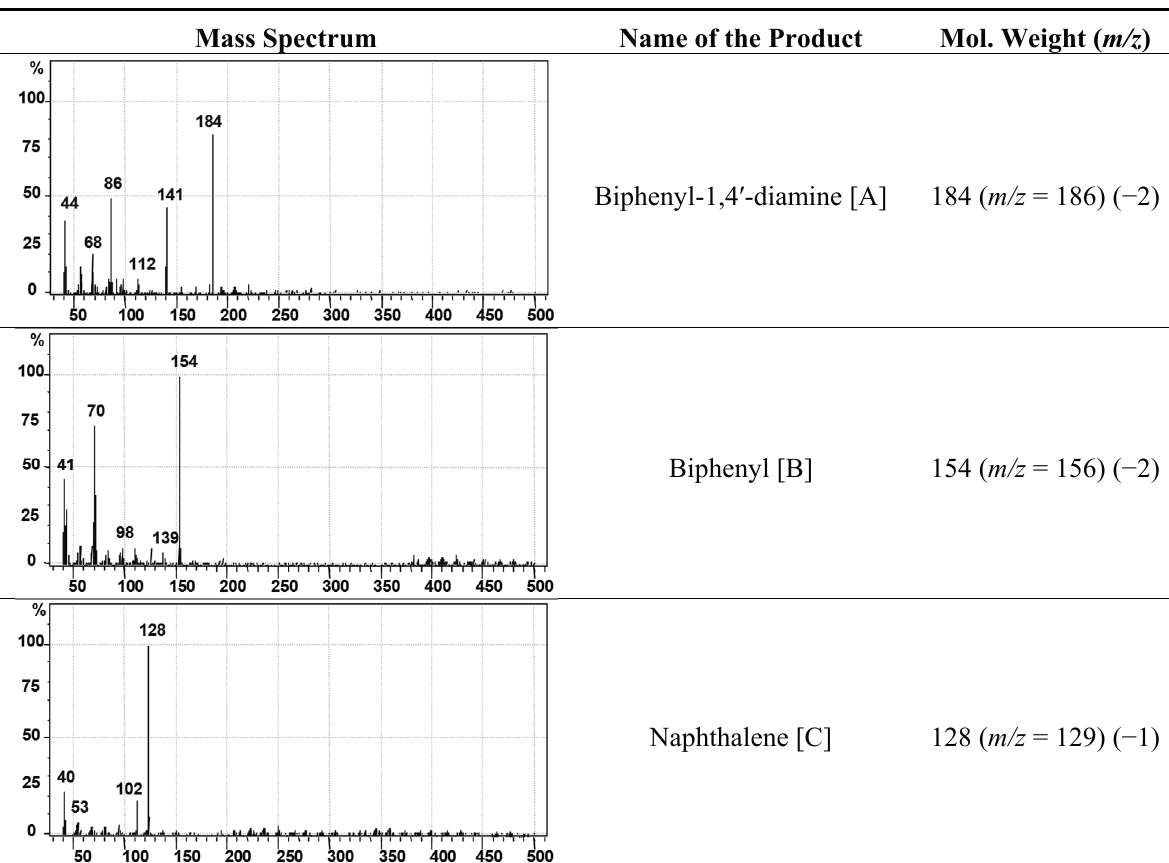
Table 4. GC–MS analysis data of degraded products of dye CR by PUF immobilized microbial consortium under upflow column